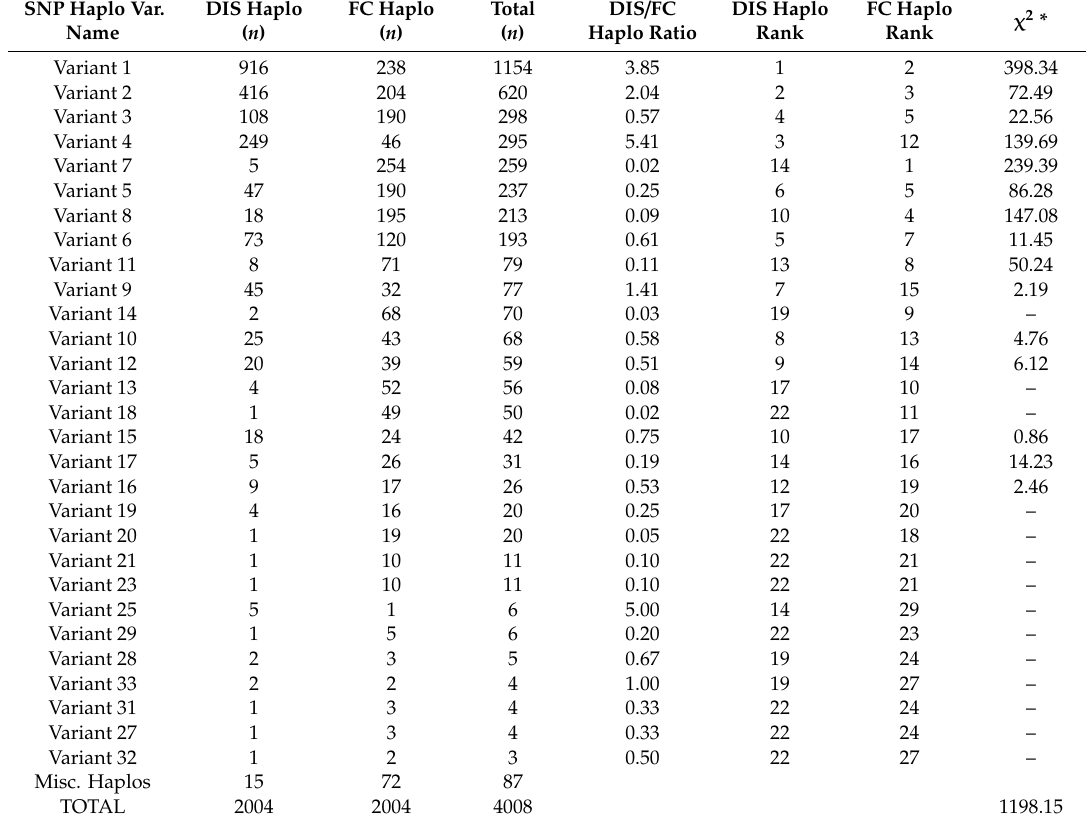
Table 6. Analysis of equalized fully-phased 27-SNP edited disease (DIS) and family control (FC) haplotypes from the ImmunoChip study 1 .